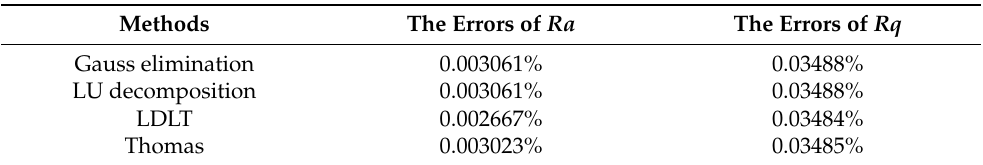
Table 5. The errors between the roughness values obtained by the four algorithms and the roughness values obtained by the Gaussian filter in the Mountains ® software.